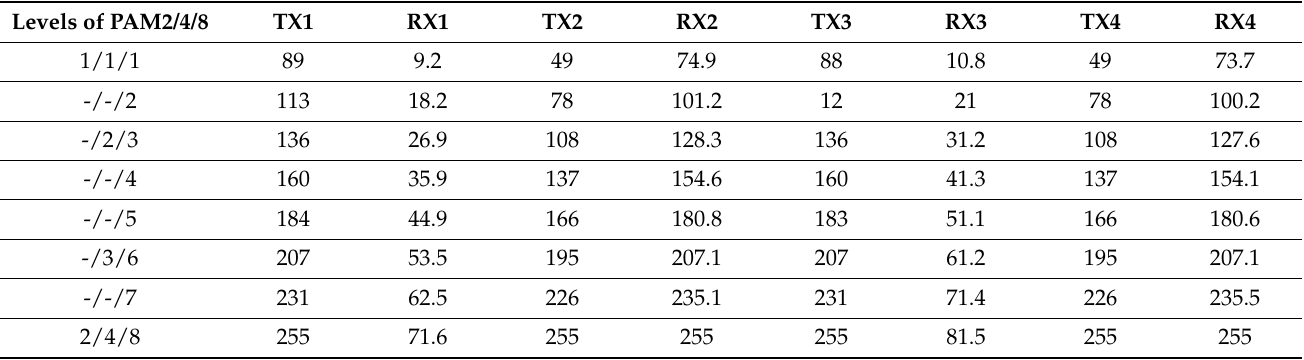
Table 2. Coding of modulation levels with grayscale mapping in four practical channels. Levels of